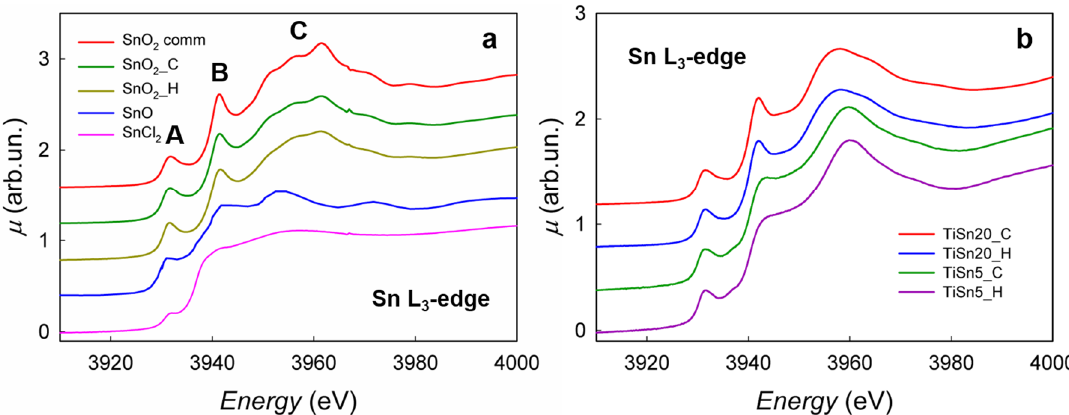
Figure 3. ( a ) XAS spectra at the Sn L 3 -edge of commercial SnO 2 , SnO, and SnCl 2 , and of SnO 2 _C and SnO 2 _H samples. ( b ) XAS spectra at the Sn L 3 -edge of TiSn20_C, TiSn20_H, TiSn5_C, and TiSn5_H. The spectra of SnO 2 synthesized via calcination (SnO 2 _C) and hydrothermal procedure (SnO 2 _H) show a close resemblance to commercial SnO 2 , despite some broadening of the main peak (White Line, WL). In XAS spectra, peaks in the close proximity of the edge can be ascribed to a specific electronic transition to empty states that are projected on the photoabsorber. The L 3 -edge is due to the transition from filled 2p 3/2 Sn states to empty Sn orbitals of either 5s or 5d nature. In particular, the peaks that are indicated as A and B in Figure 3 are due to the transition 2p 3/2 5s 1/2 , while the whole region that is indicated as C is due to transition to empty 5d 5/2 orbitals [26]. In SnO 2 , tin has